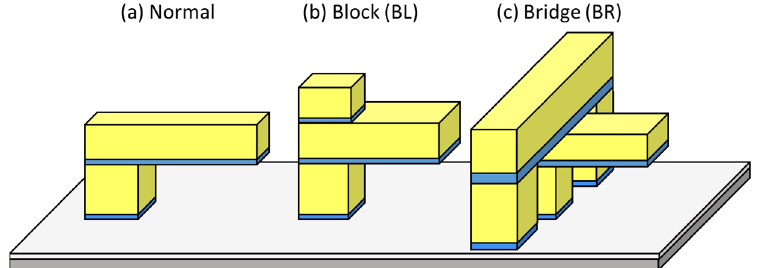
Figure 2. Schematics of the ( a ) normal, ( b ) block and ( c ) bridge type micro-cantilevers.